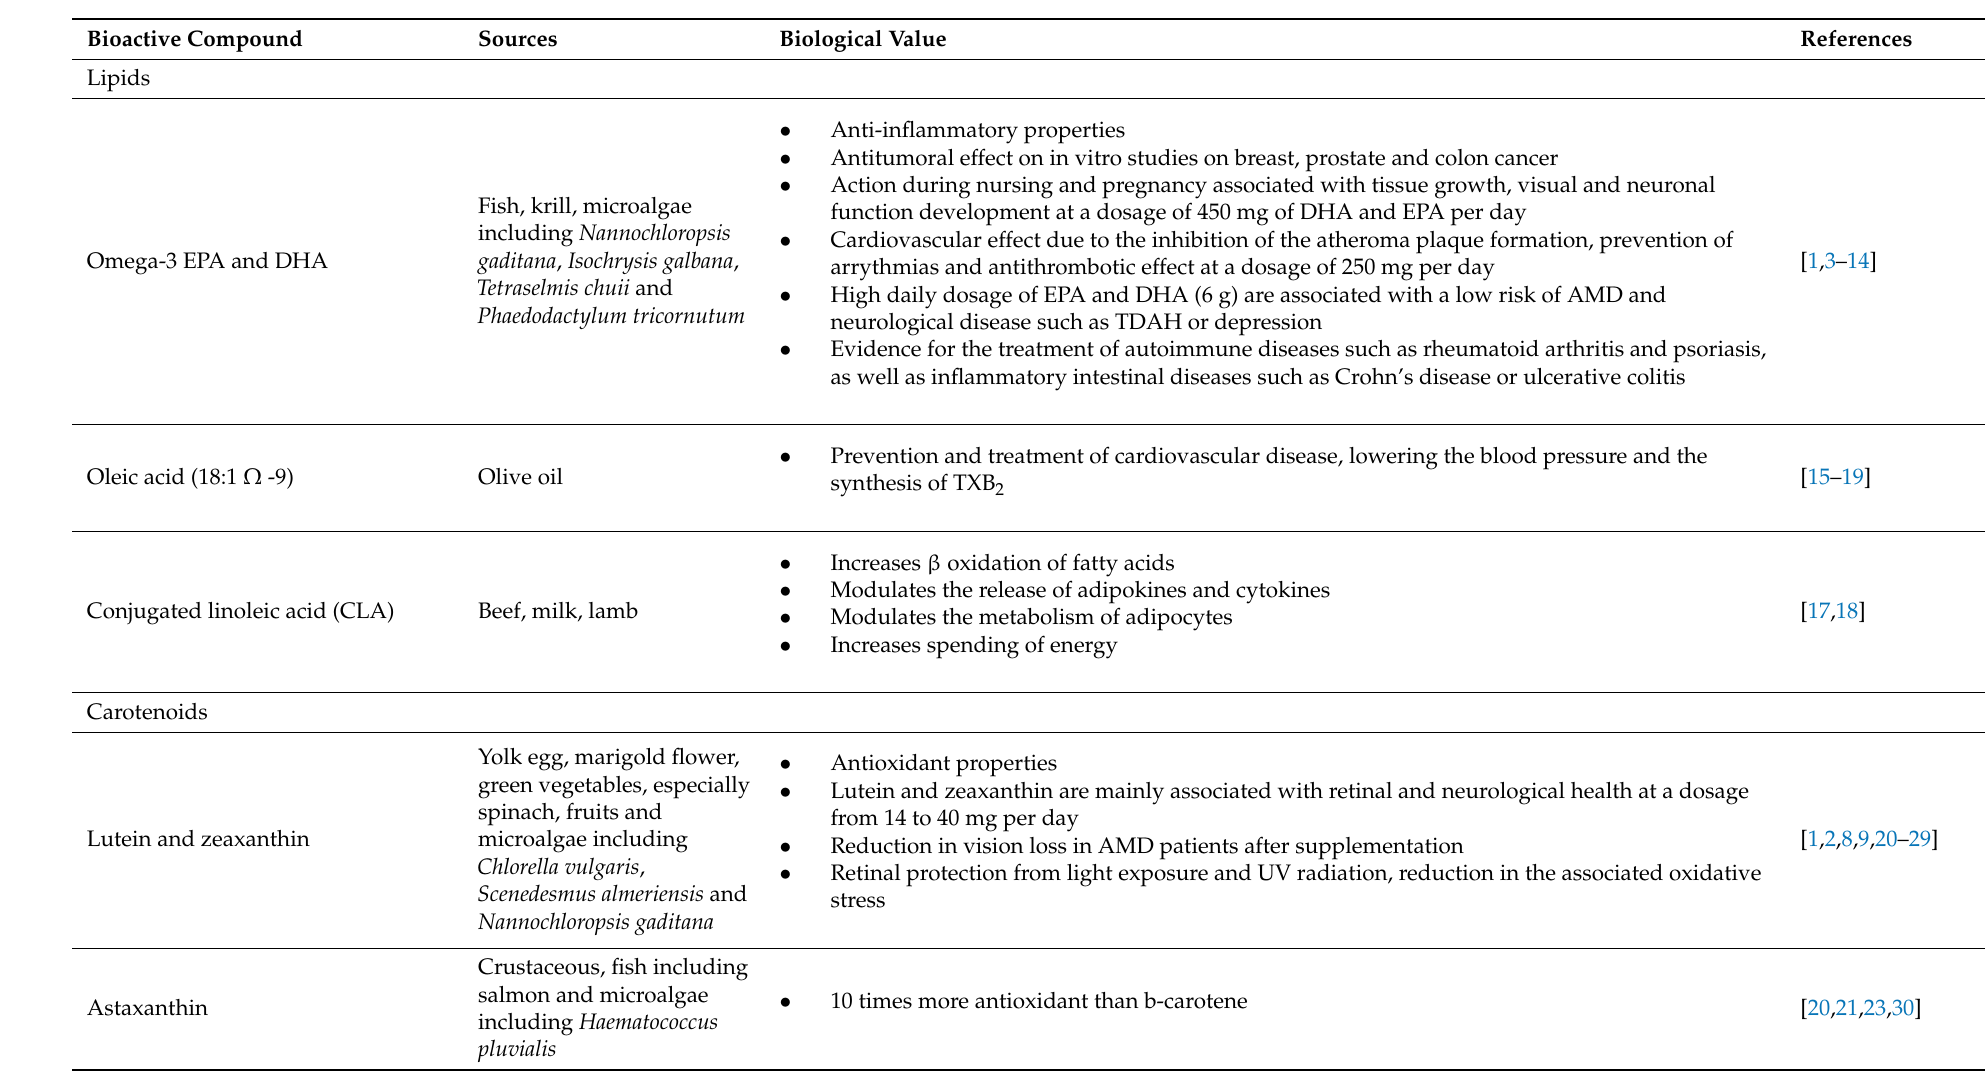
Table 1. Source of common nutraceuticals and biological properties, including bioactive lipids, carotenoids, phenolic compounds and bioactive